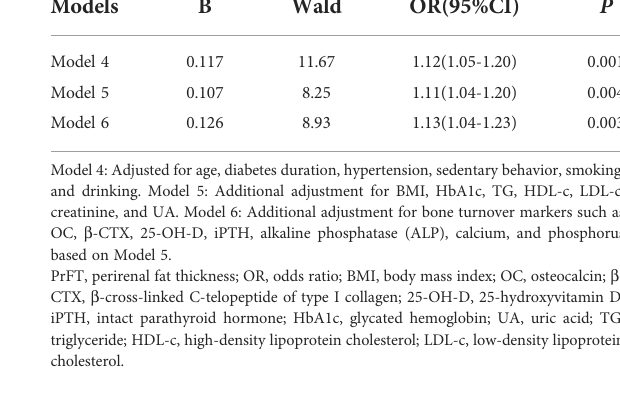
TABLE 3 Correlations between PrFT and BTMs and BMD in postmenopausal women with T2DM. Variable